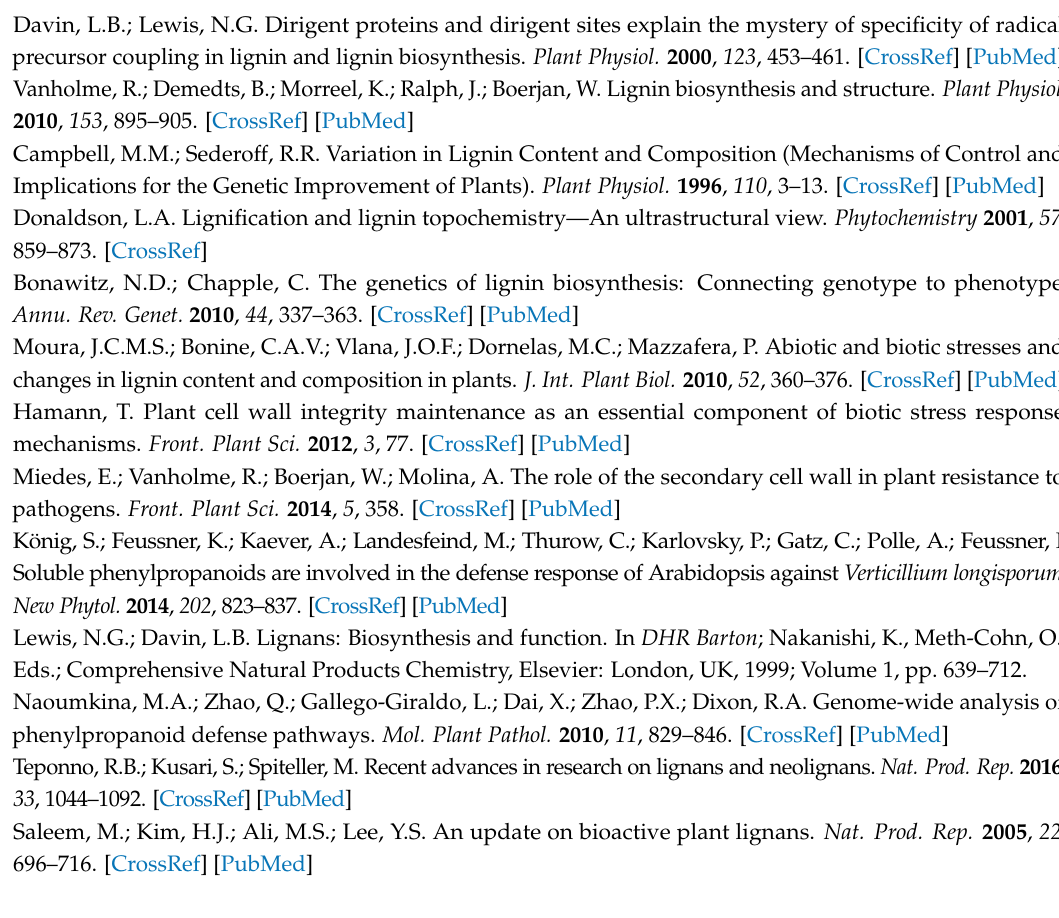
Supplementary Materials: The following are available online, Figure S1: Alignment of amino acid sequences of OsCADs and other plant CADs, Figure S2: Phylogenetic analysis of OsCADs and other plant CADs, Figure S3: Quantitative real-time PCR analysis of OsCAD gene expression in rice tissues from different developmental stages, Figure S4: In silico transcriptomic analysis of OsCAD gene expression in response to biotic stress, Figure S5: In silico transcriptomic analysis of OsCAD expression in response to abiotic stress, Table S1: Sequence homologies between the deduced amino acid sequences of the OsCADs and bona fide CADs from other plants, Table S2: Primer sequences and PCR conditions for the cloning of OsCAD s, Table S3: Primer sequences and PCR conditions for quantitative real-time PCR analysis of OsCAD